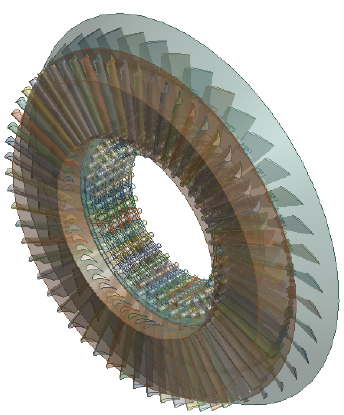
Figure 2. A full-circle model of stator and rotor blades in the low pressure stage.